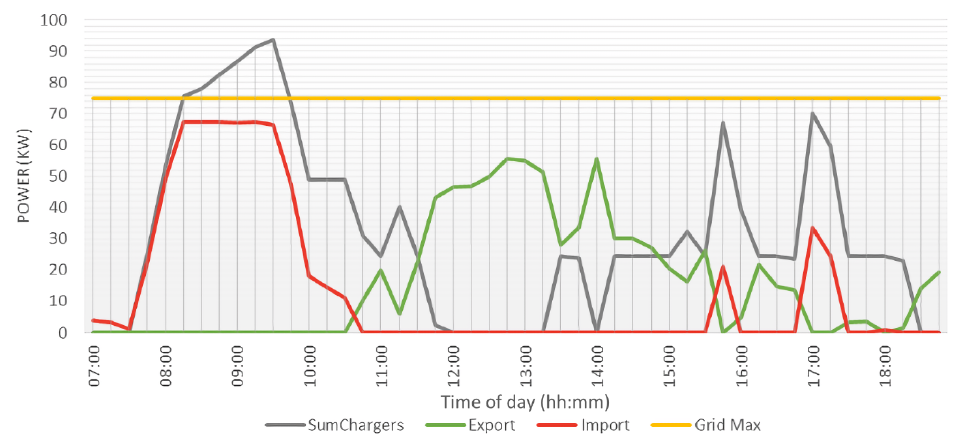
Figure 10. Energy patterns during a summer day. Shows the total charging power (grey) and power export/import